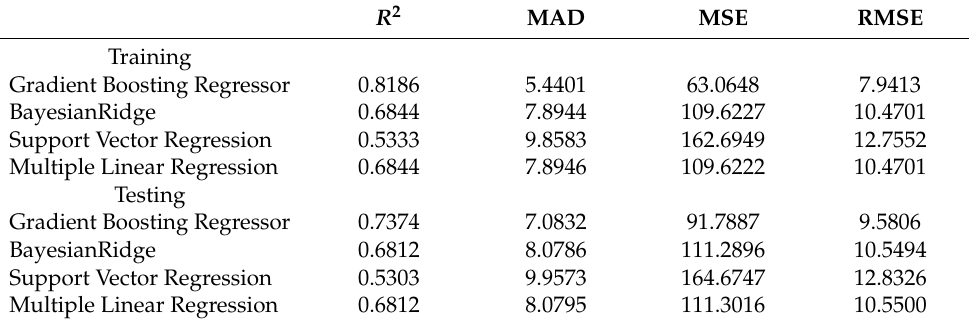
Table 5. Results comparison of GBR with the other three methods on disease datasets.